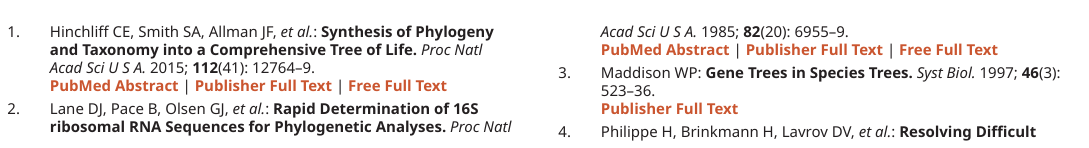
Data are available under the terms of the Creative Commons Zero “No rights reserved” data waiver (CC0 1.0 Public domain